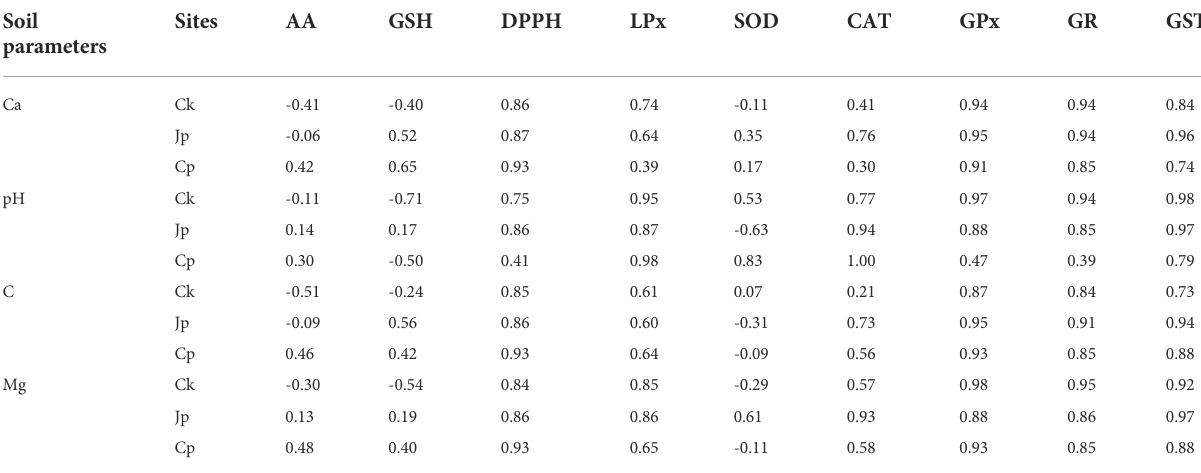
TABLE 3 Correlation between oxidative stress physiology indices and pedological factors. Soil Sites parameters